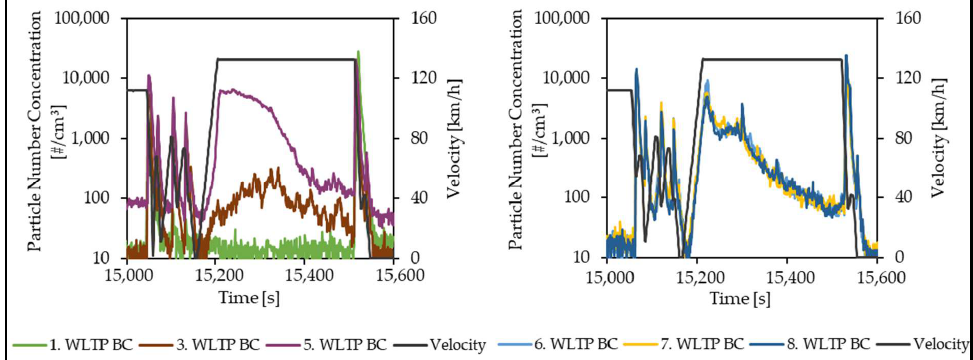
Figure 11. Evolution of secondary emissions (SPN measured with CPC) for brake shoe pair 2 during an excerpt of WLTP Brake Cycle Trip 10. Because of their radial adjustment, drum brakes have strong retraction elements in the form of springs. In the first WTLP Brake Cycle, no increase in the particle number concentration can be detected over the constant speed of 132.5 km/h. This might be a sign